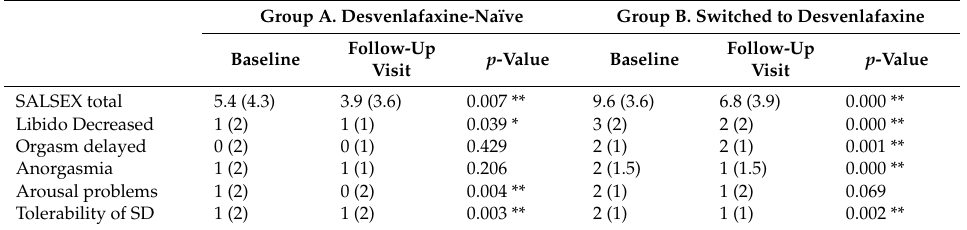
Table 1. Descriptive statistics of SALSEX questionnaire of groups A and B. Baseline vs. follow-up visit.